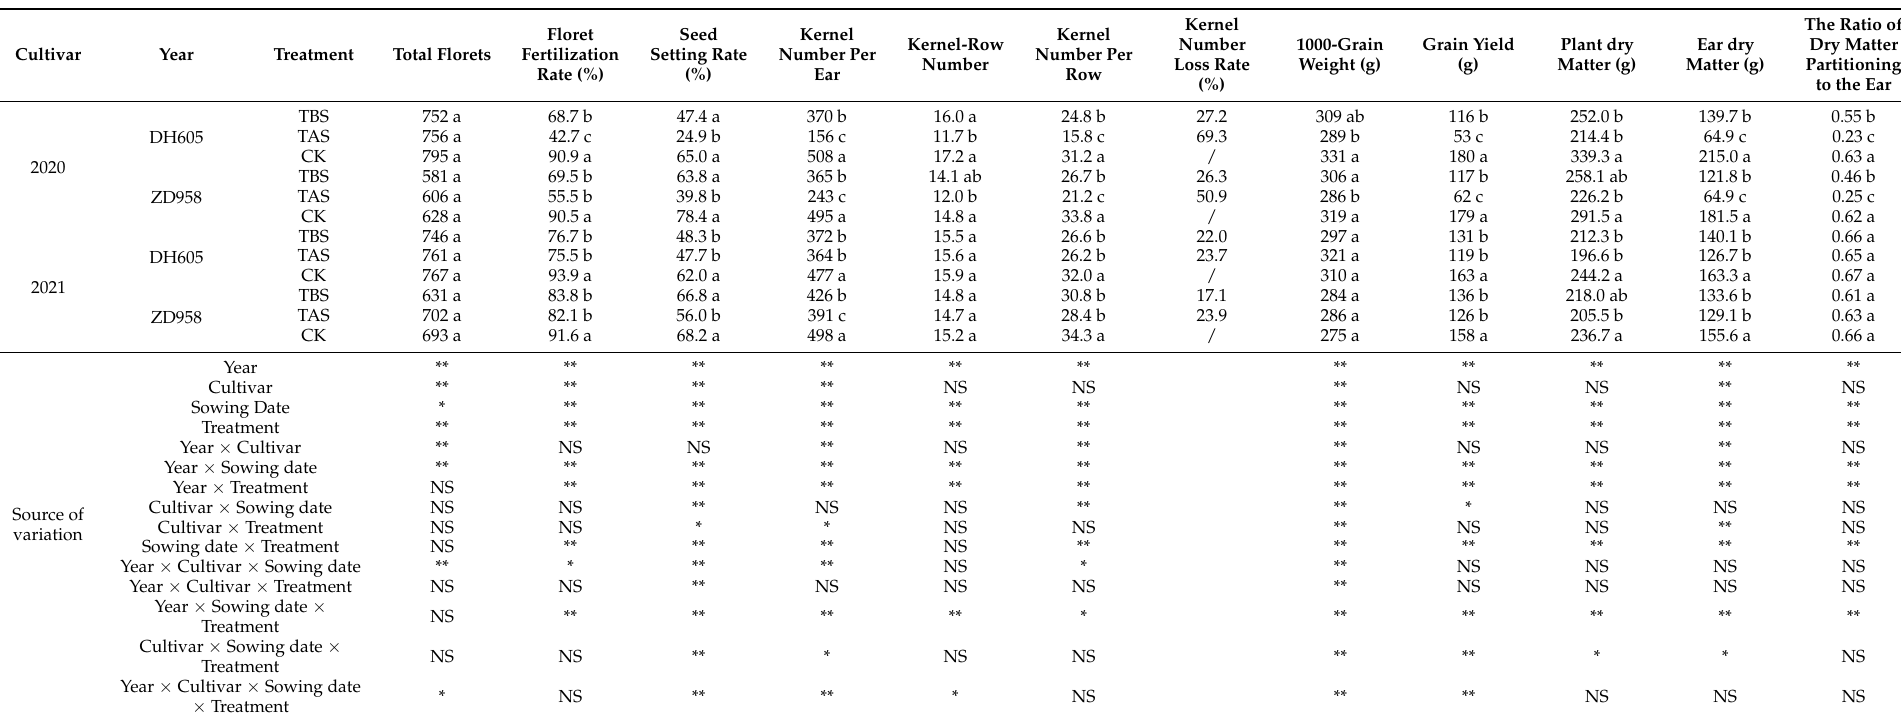
Table 2. Kernel number per ear, 1000-grain weight, yield formation process and biomass accumulation under different heat stress treatments. Values for the same treatment were the mean values under three sowing dates. Values followed by different letters within the same column for a cultivar are significantly different at p = 0.05. **, significantly different at p < 0.01, *, significantly different at p < 0.05, NS, the difference was not significant. The same as